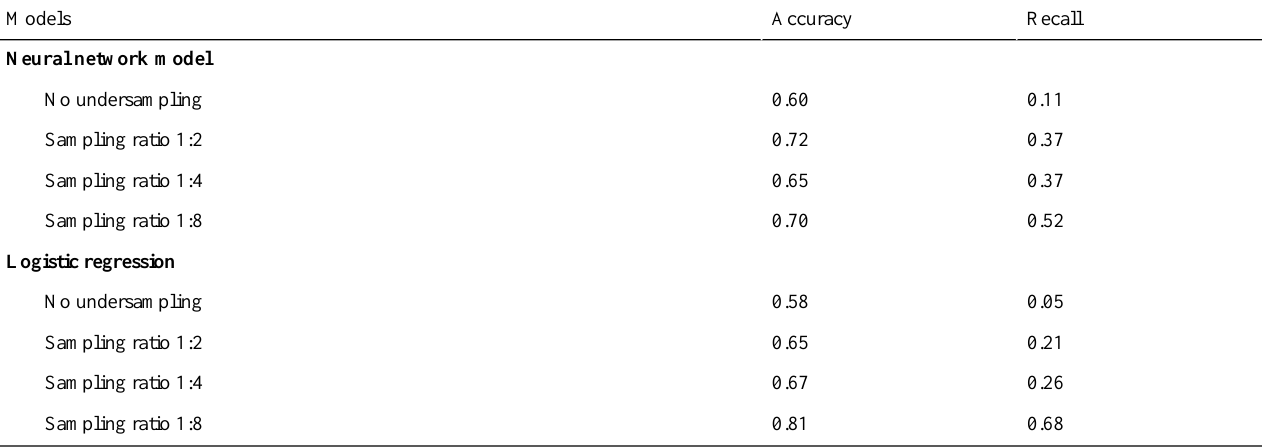
Table 3. Accuracy and recall of each neural network model and logistic regression with a cutoff of >0.5 for the dichotomous classification.